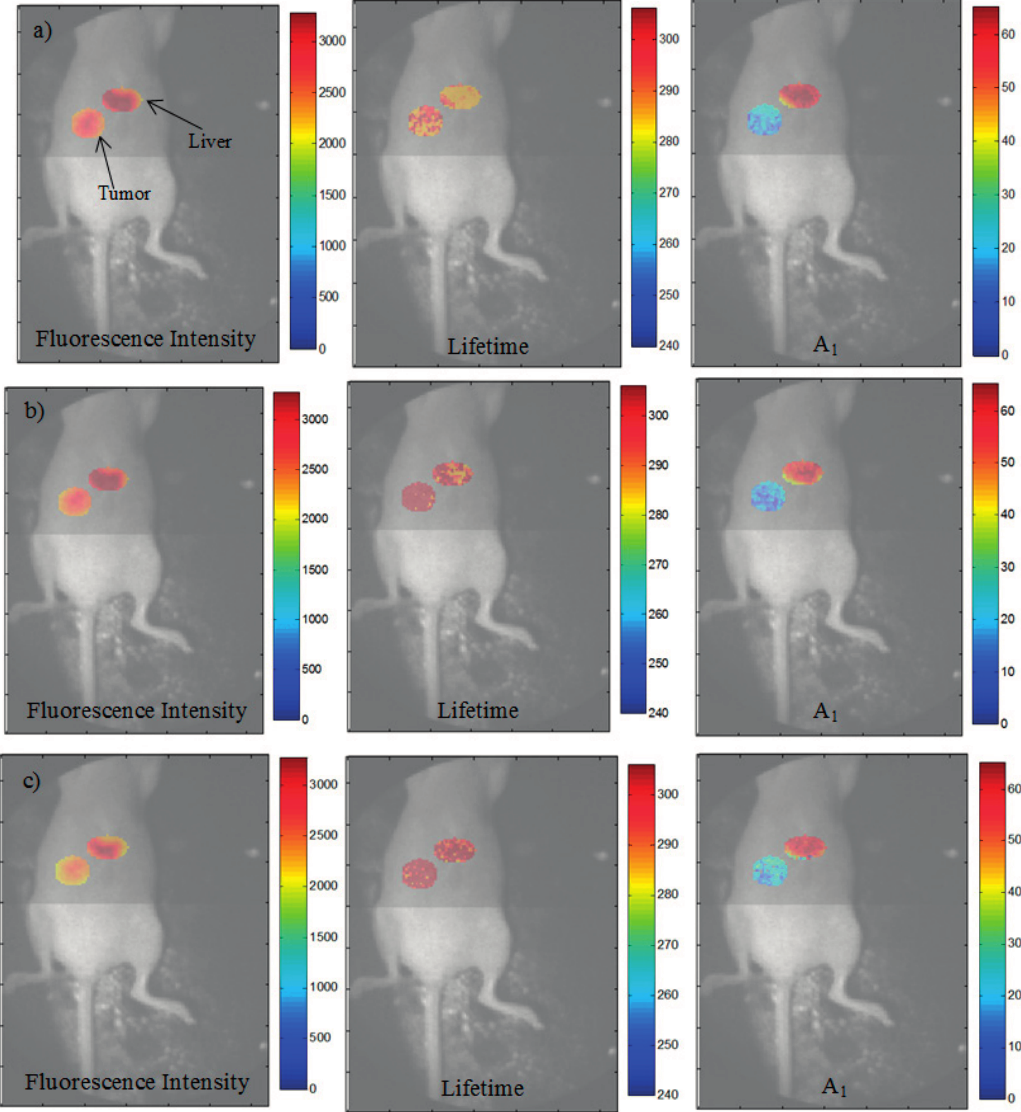
Figure 6. Fluorescence intensity, estimated τ 1 , and estimated A 1 for the labeled organs of interest and gate width of ( a ) 300 ps, ( b ) 600 ps, and ( c ) 1000 ps. The photon counts were set to 3000 counts at the maximum of the TPSF during image acquisition (A:D ratio of 2:1